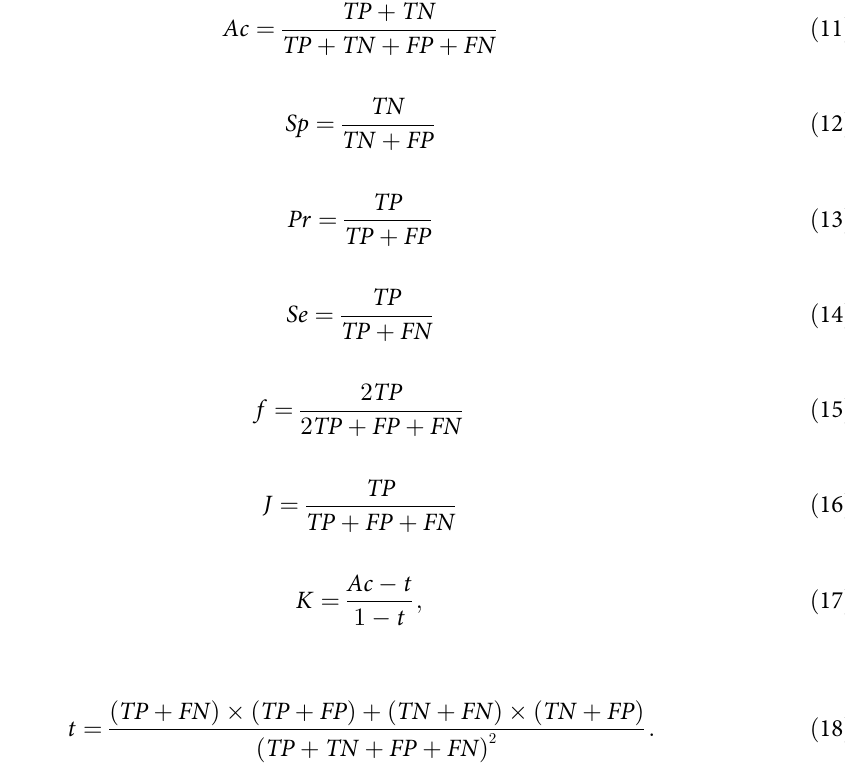
Table 1 summarizes the pixel classification of true positives (TP), false positives (FP), true negatives (TN), and false negatives